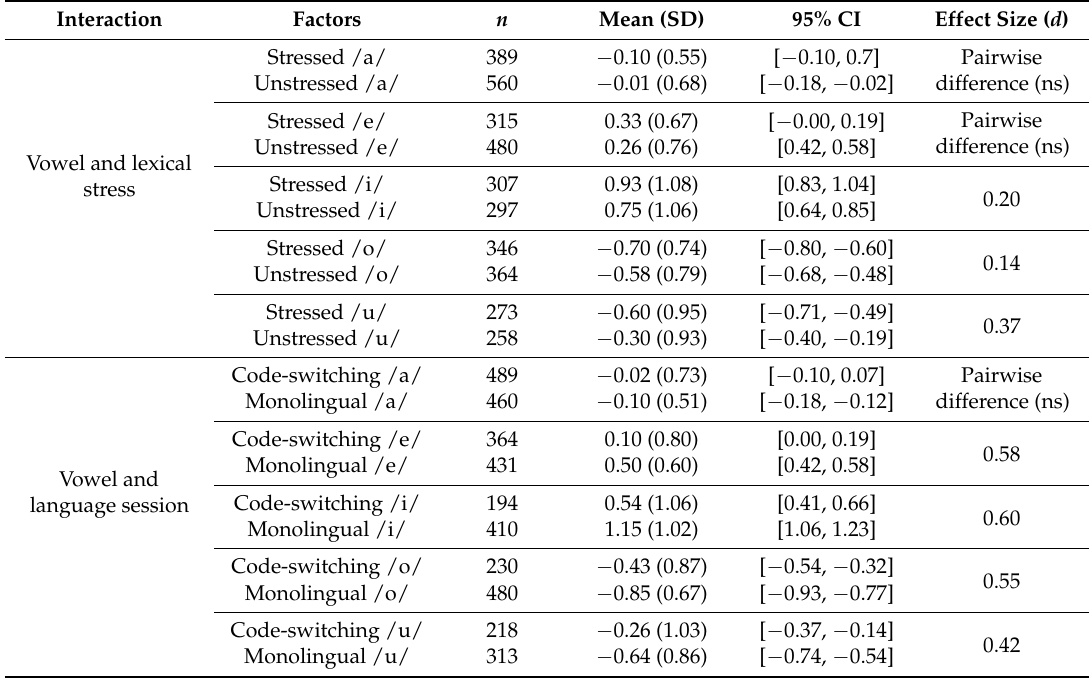
Table 4. Descriptive results for normalized F2 values.